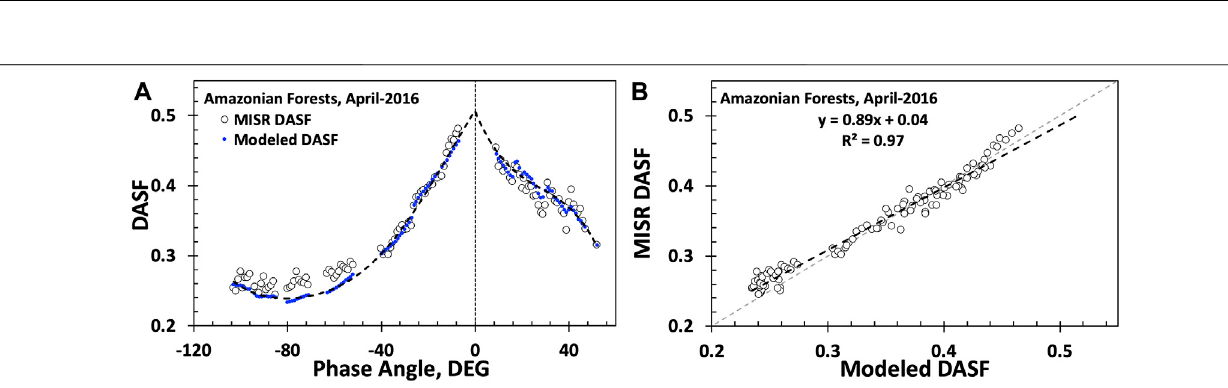
FIGURE5|(A) . Hot spotparameter h vs. cos(SZA). (B) Theeffectiveextinction coef fi cientvsMODIS LAIderivedfrom monthlyMISRDASFfortheperiod between 2017 and 2019.